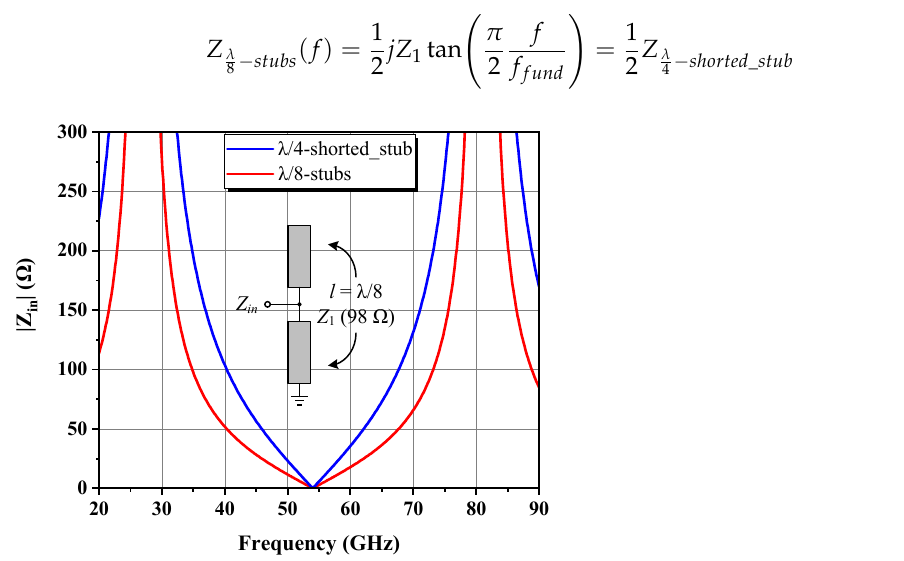
Figure 10. Impedance response of the ideal suggested even harmonic trap circuit designed at f 0 compared with that of the shorted λ /4 transmission line.